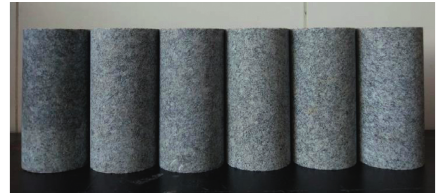
Figure 1: The granite samples and their optical image.